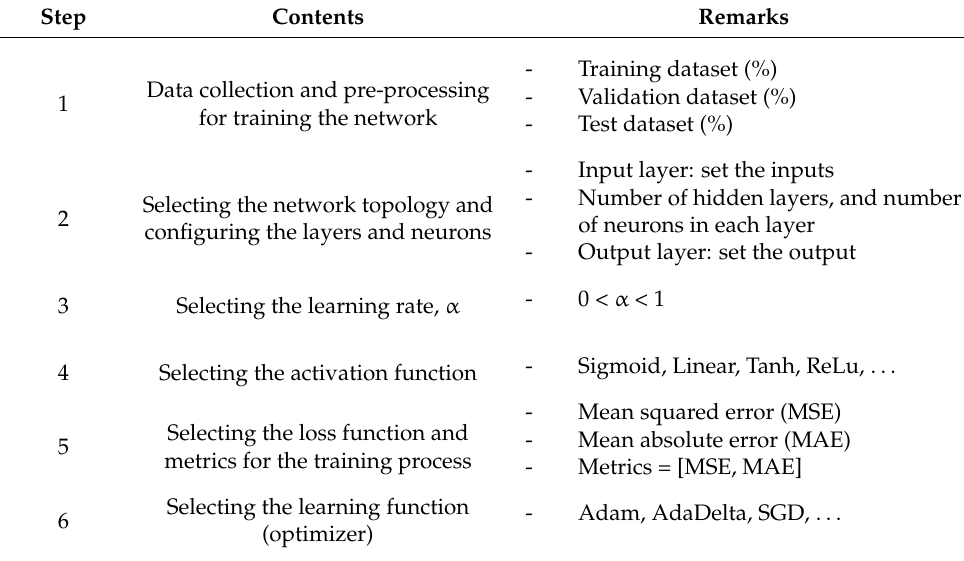
Table 3. Design process and design factors for the